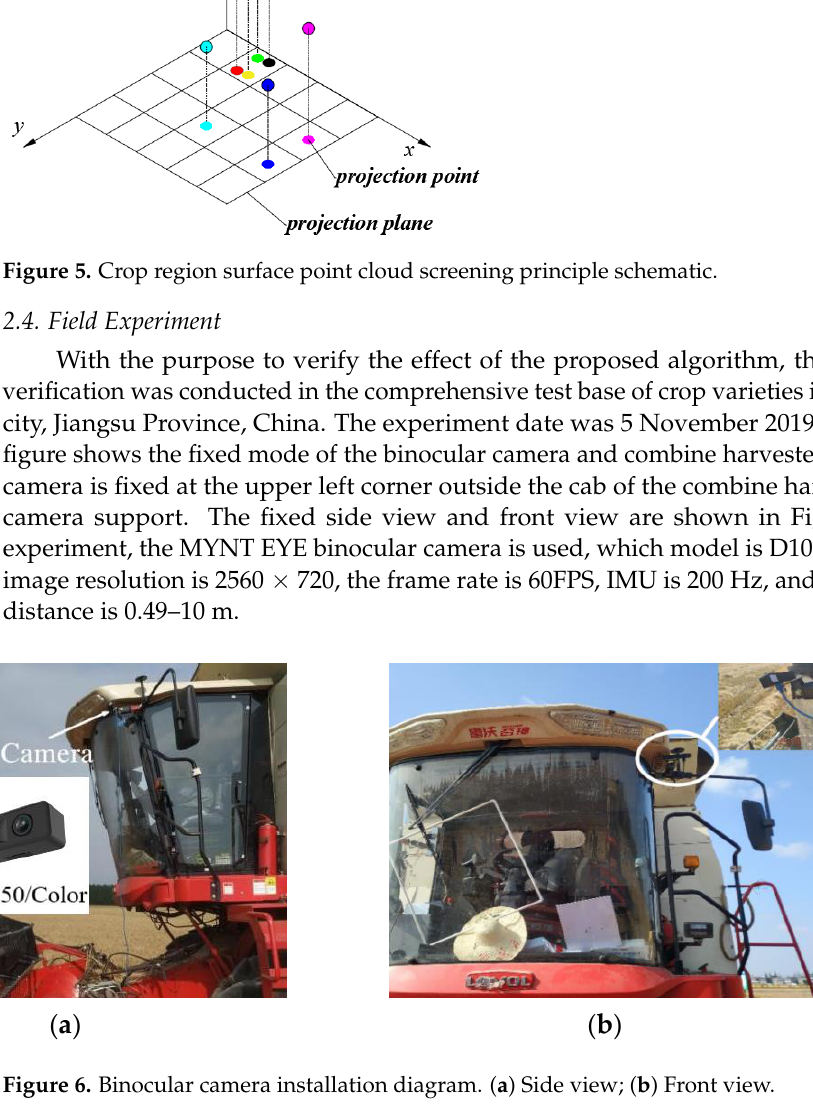
Table 3. Manual measured value of wheat height.